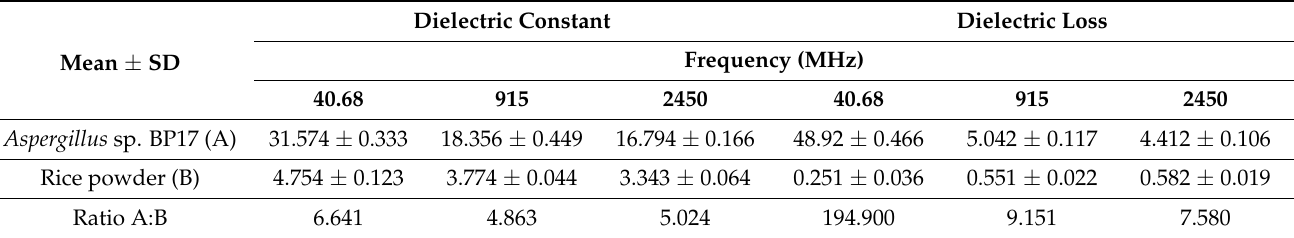
Table 1. Dielectric properties of Aspergillus sp. BP17 and rice